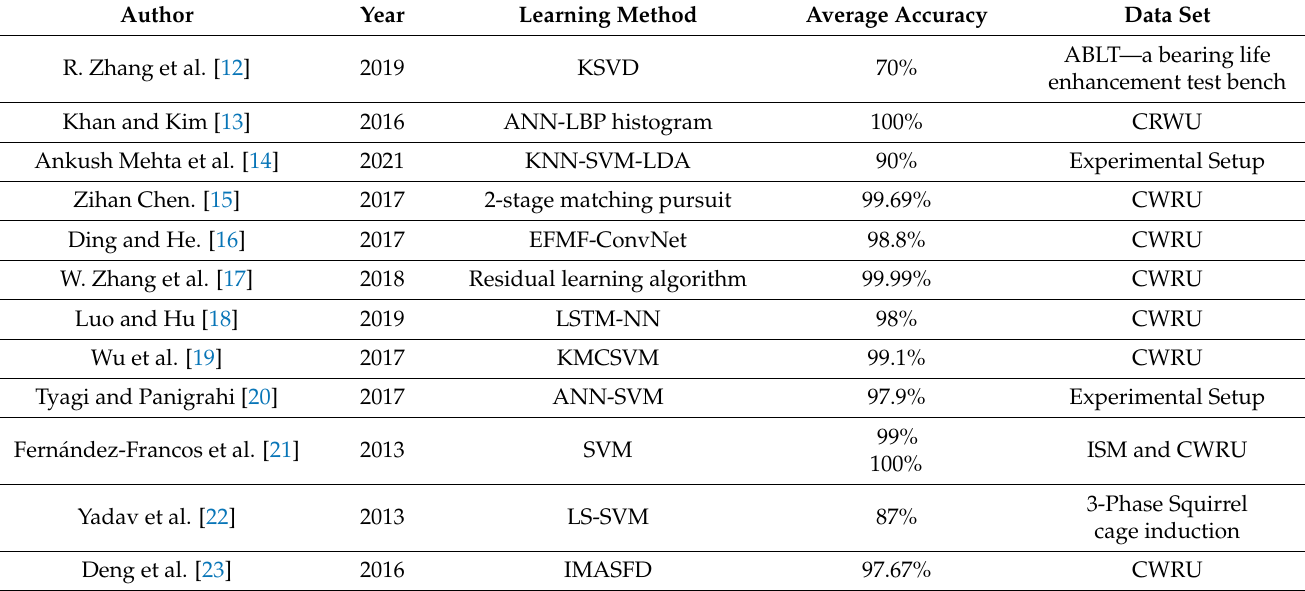
Table 3. Comparison of classical algorithms for fault bearing diagnosis.